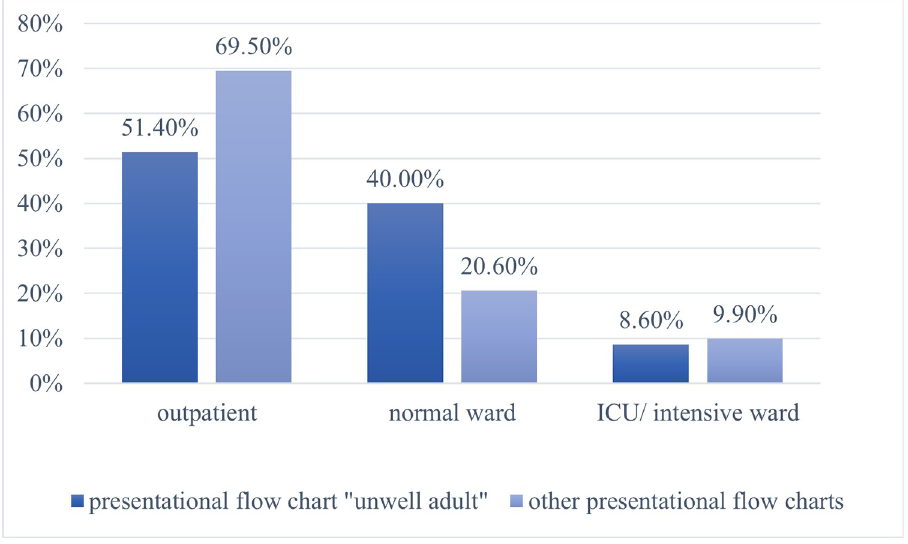
Fig 4. Level of care of the presentational flow chart “unwell adult” vs. the other presentational flow charts (p < 0.001).